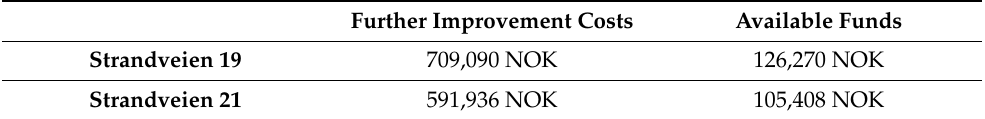
Table 3. Estimated renovation costs compared to available funds (Trondheim Kommune, 2016).